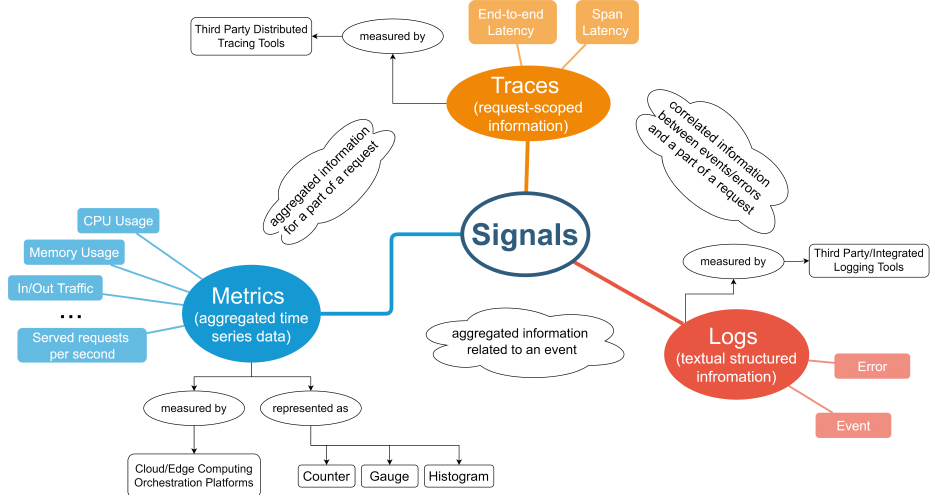
Figure 1. Classification of signals into metrics, logs and